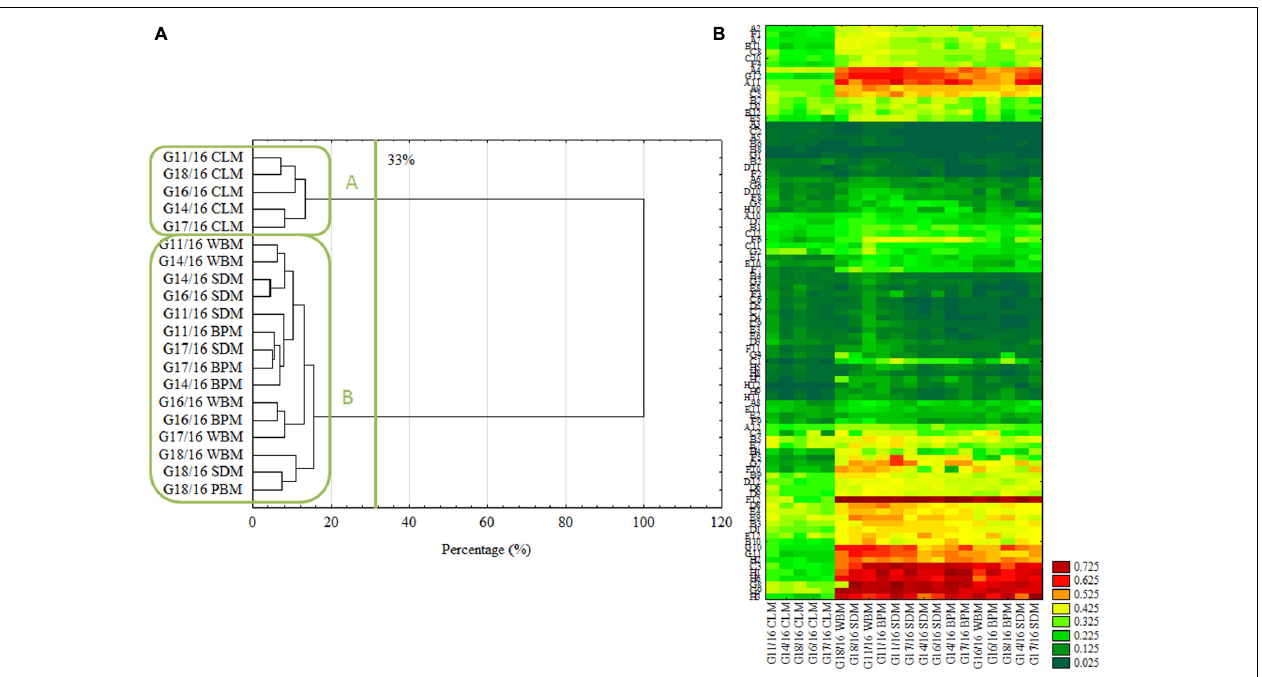
FIGURE 4 | Intraspecific metabolic diversity of P. setifera isolates as influenced by preculturing. (A) Clustering according to the stringent Sneath’s criterion (33%) and less restrictive criterion (66%), (B) the cluster analysis depending on carbon-compound utilization located in the FF plate R (cid:13) . For explanations: please see Figure 1 . Carbon compounds decoding according to (Fr ˛ac,